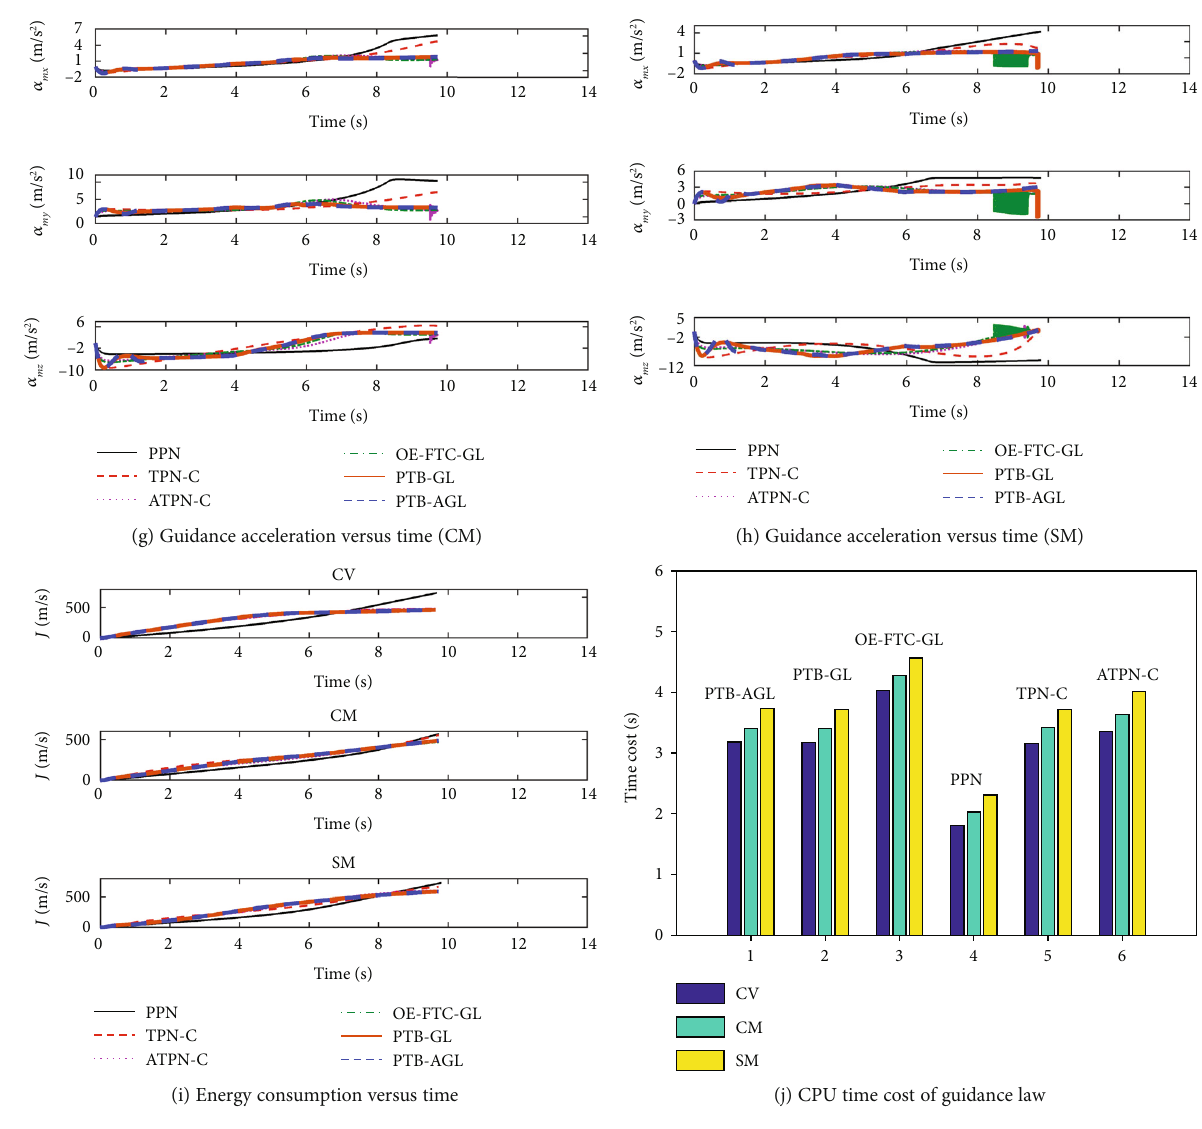
Figure 8: Simulation results under Case 2. Table 6: Summary of guidance performance — Case